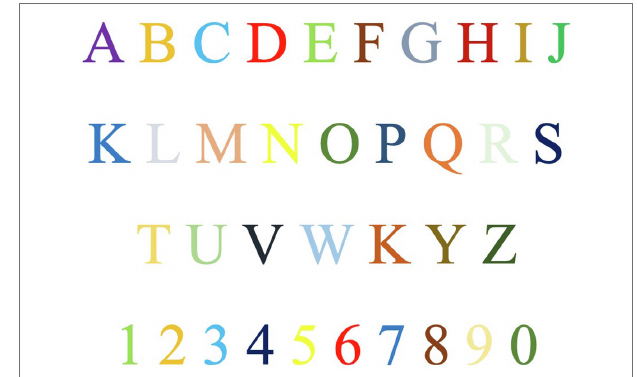
FIGURE 4 | Example of a grapheme-color